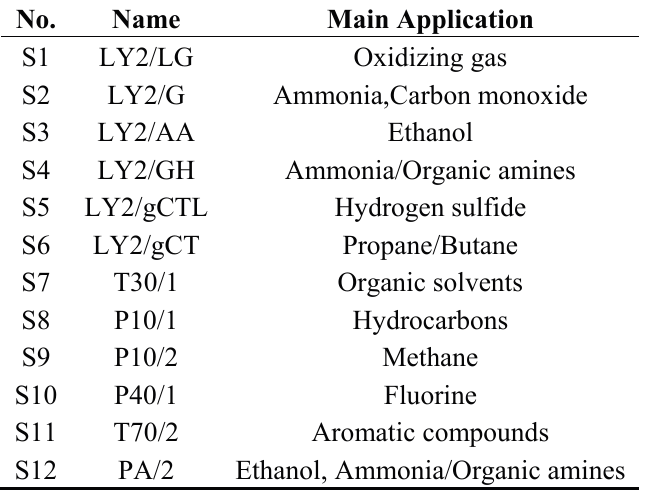
Table 2. The components and main application of sensors of α -FOX3000 EN.